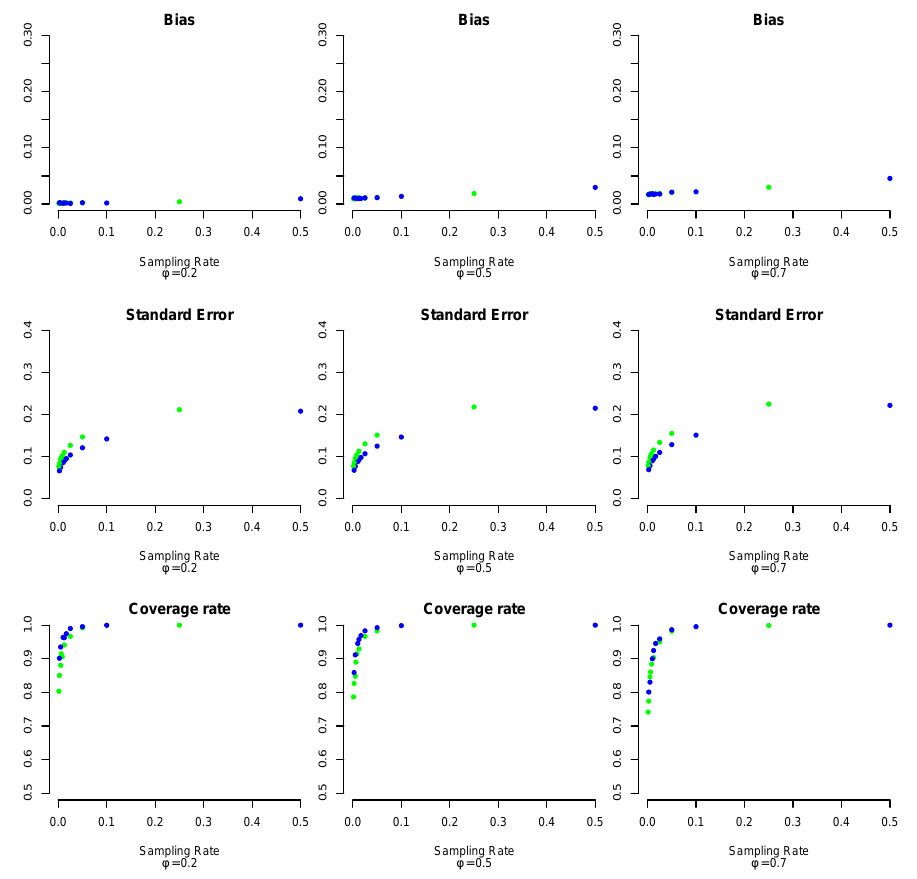
Figure 7. Bias, standard error, and coverage rate for the proportion parameter, according to the ratio and φ . Blue points n IS = 250, green points n IS =